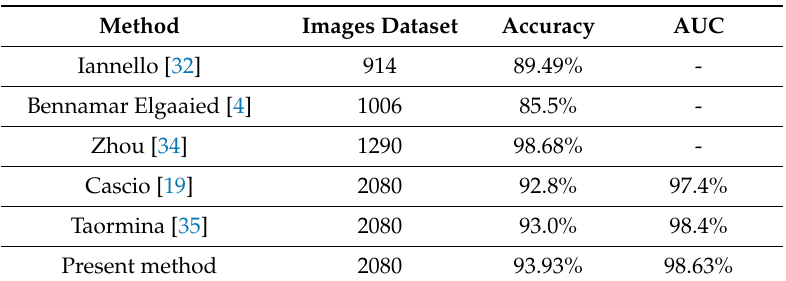
Table 8. Performance